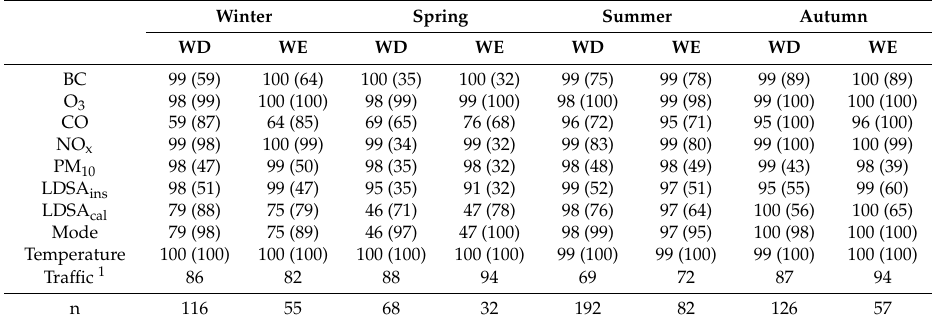
Table 2. Data completeness (%) of the two data sets pertaining to the key air quality and meteorological parameters in Mäkelänkatu and Kumpula (in parenthesis). The last row shows number of days that fall on the category. WD and WE are the abbreviations of workdays and weekends